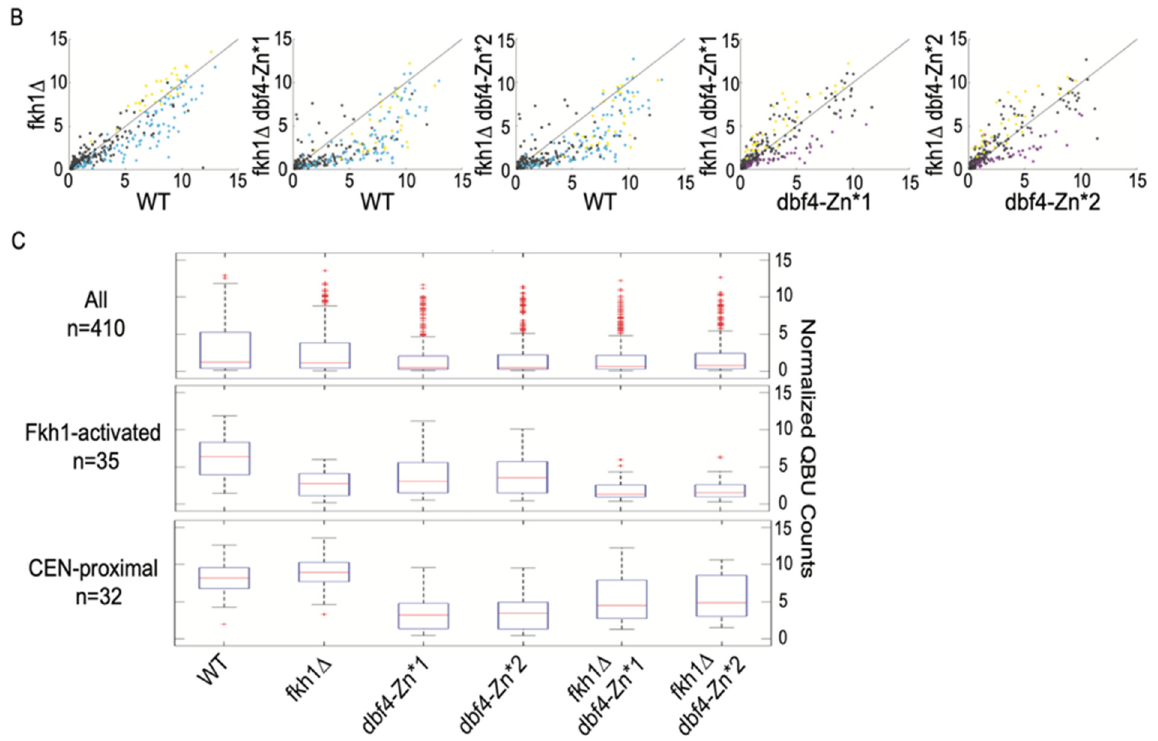
Figure 4. Dbf4-Zn* retains Fkh1 origin stimulation. Strains described in Figures 1 and 2 legends were synchronized in G1 phase, released into S phase with HU for 60 min, and harvested for QBU analysis. ( A ) QBU values averaged for two replicates and scale-normalized across strains are shown for representative chromosome XV; origins and origin sub-groups are indicated with color-coded circles below the x -axis. ( B ) Two-dimensional scatter plots comparing QBU signals averaged across 500 bp regions centered on 410 confirmed origins; origins and sub-groups are color-coded as indicated. ( C ) Boxplot distributions of averaged QBU counts across 500 bp regions aligned on origins of the indicated groups; the number of origins in each group is indicated within parentheses; results of statistical analyses are given in Table S1.